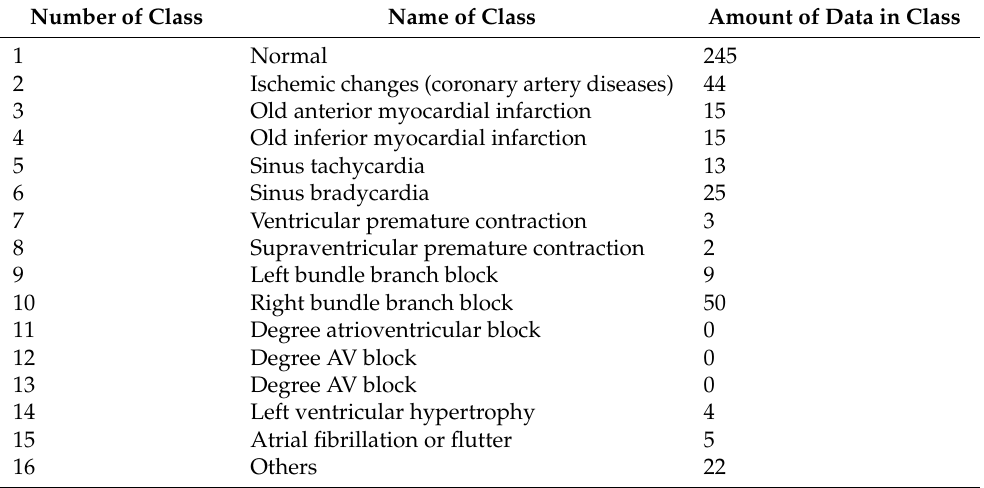
Table 3. The UCI database arrhythmia classes [43].